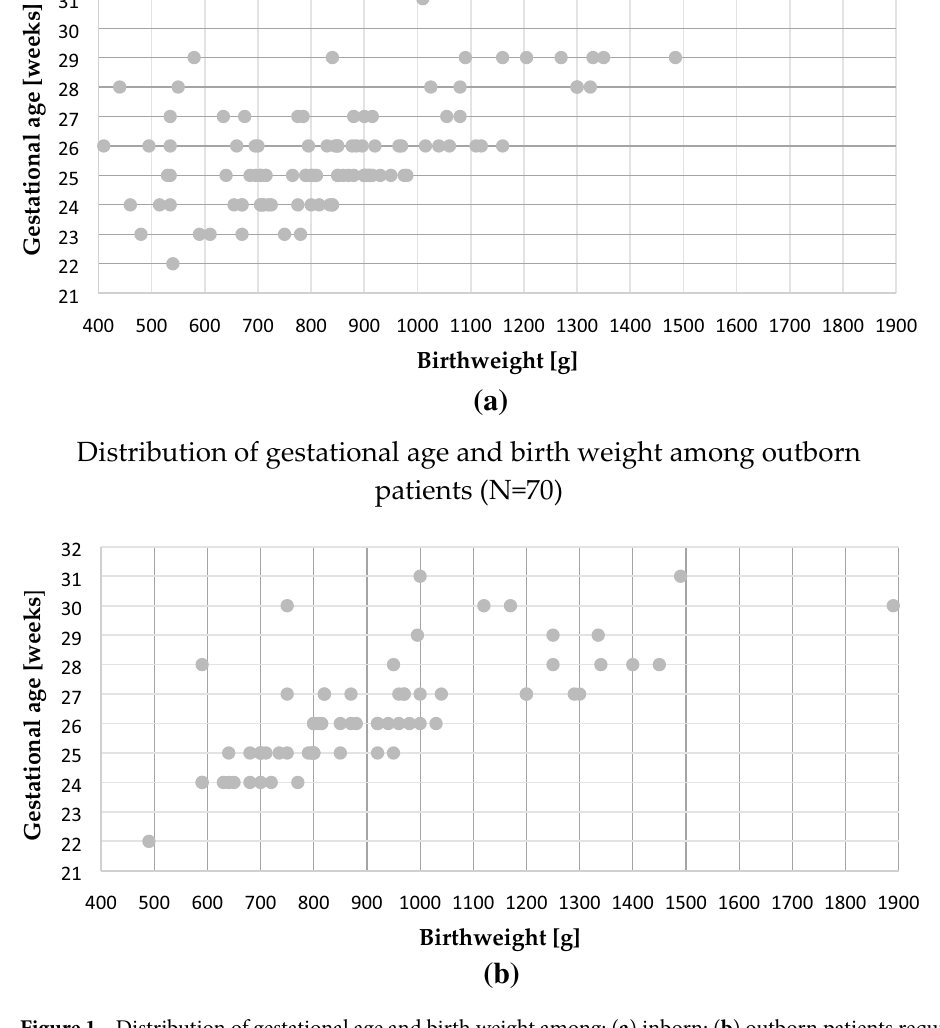
Figure 1. Distribution of gestational age and birth weight among: ( a ) inborn; ( b ) outborn patients requiring treatment, in the years